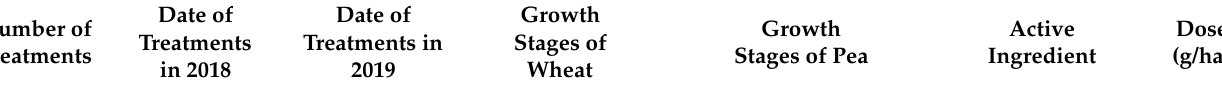
Table 1. Dates and doses of herbicide treatments applied at different growth stages in both experiment years, 2018 and